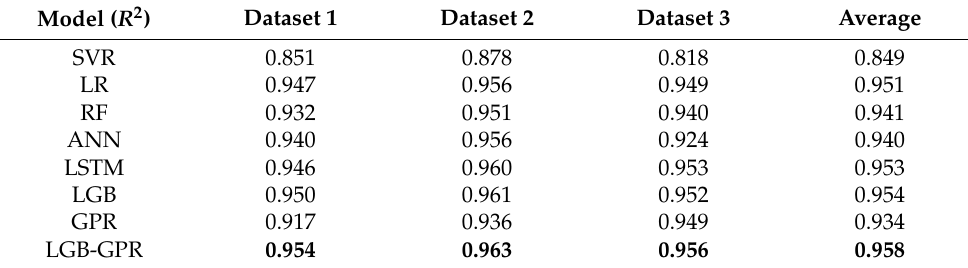
Table 2. R 2 score results statistics